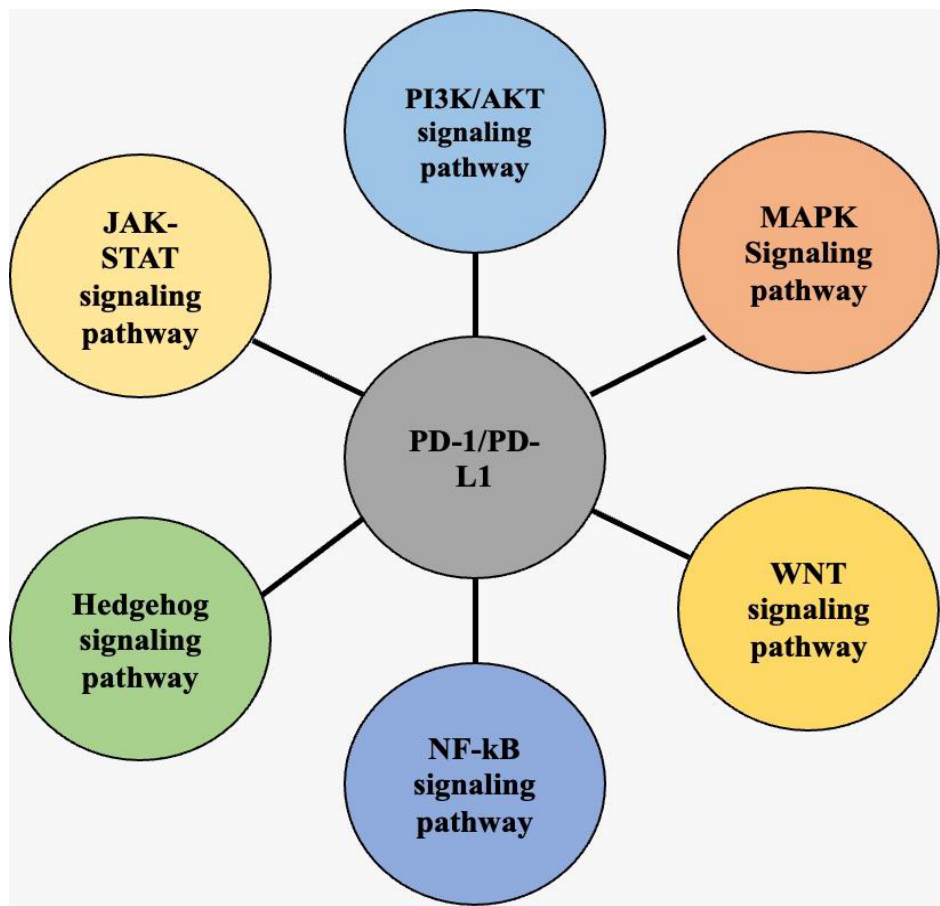
Figure 2. Depiction of different pathways that regulate expression of PD-1/PD-L1. The PI3K/AKT pathway, WNT pathway, MAPK pathway, NF- κ B pathway, JAK/STAT pathway, and Hedgehog (Hh) pathway stimulate the expression of PD-1/PD-L1